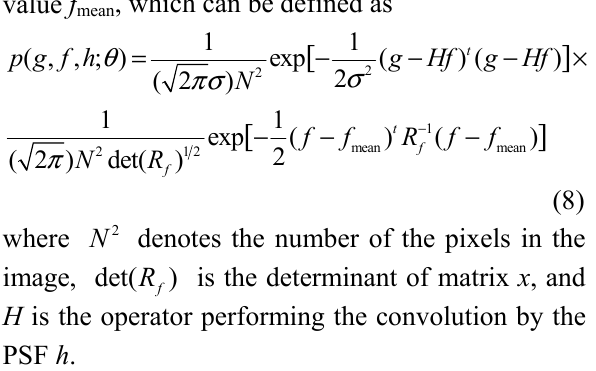
Algorithm 1 Steps for our proposed